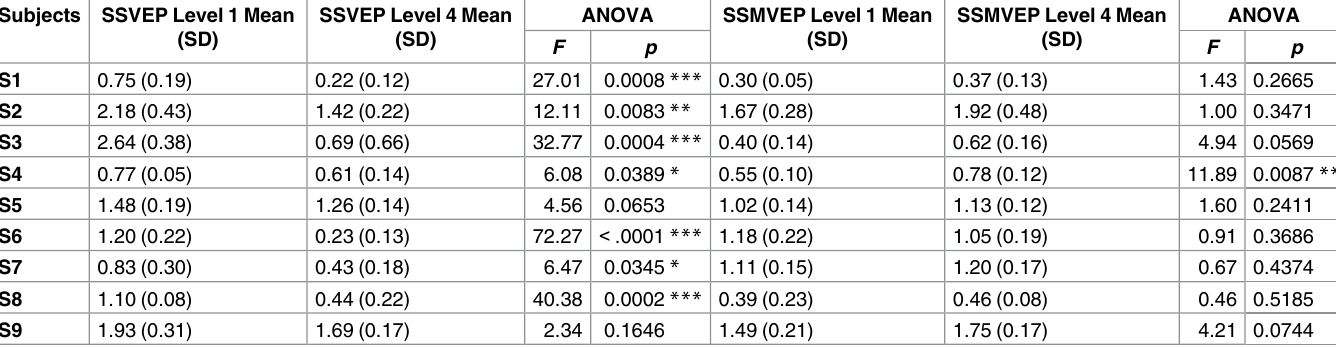
Table 1. Statistical summary of the amplitude variations under fatigue level 1 and 4 for individual subjects. Subjects SSVEP Level 1 Mean (SD)